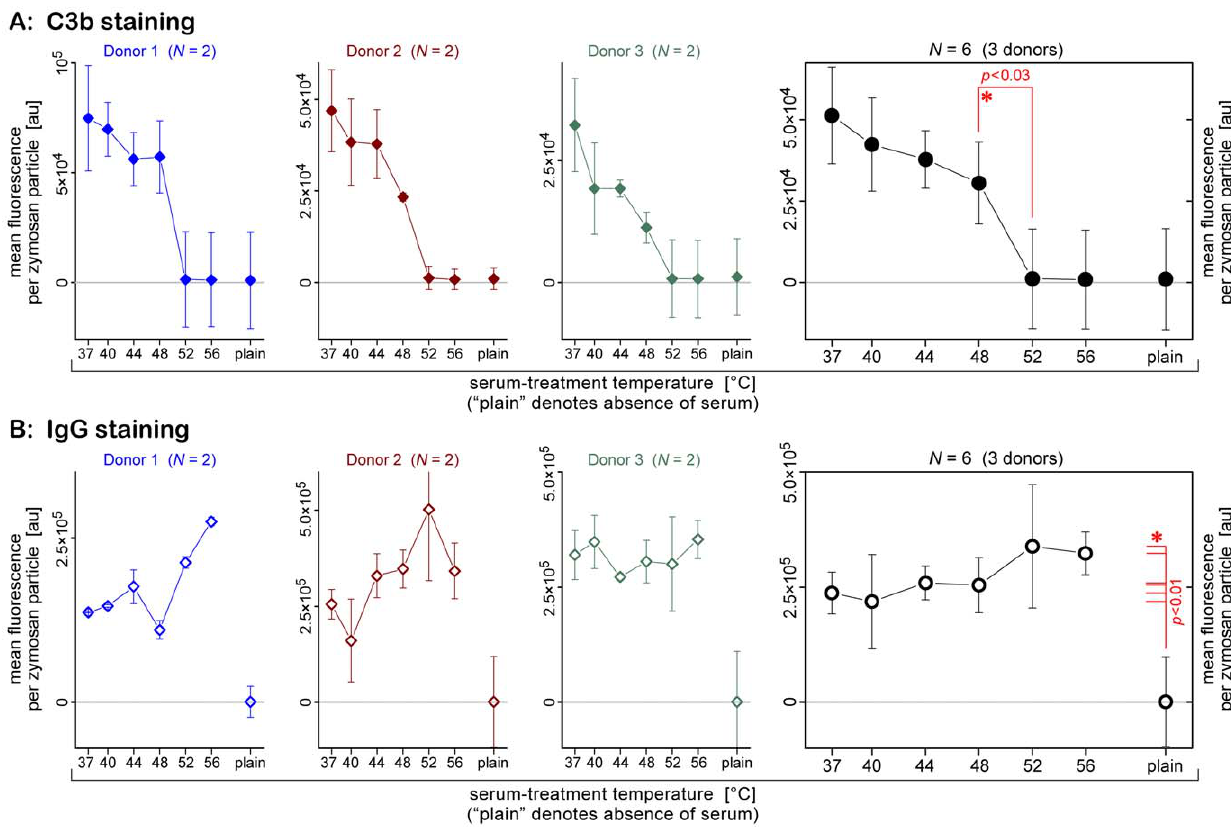
Figure 2. Summary of the FCM assessment of the temperature-dependent deposition of C3b and IgG onto the surface of serum- opsonized zymosan. ( A ) Results of staining with FITC-conjugated anti-C3b. ( B ) Results of staining with Alexa-Fluor H -488-conjugated anti-IgG. The first three columns depict example data obtained with sera from different, healthy donors. The rightmost column summarizes the results for a total of 3 donors. Values are block-centered means 6 SD.